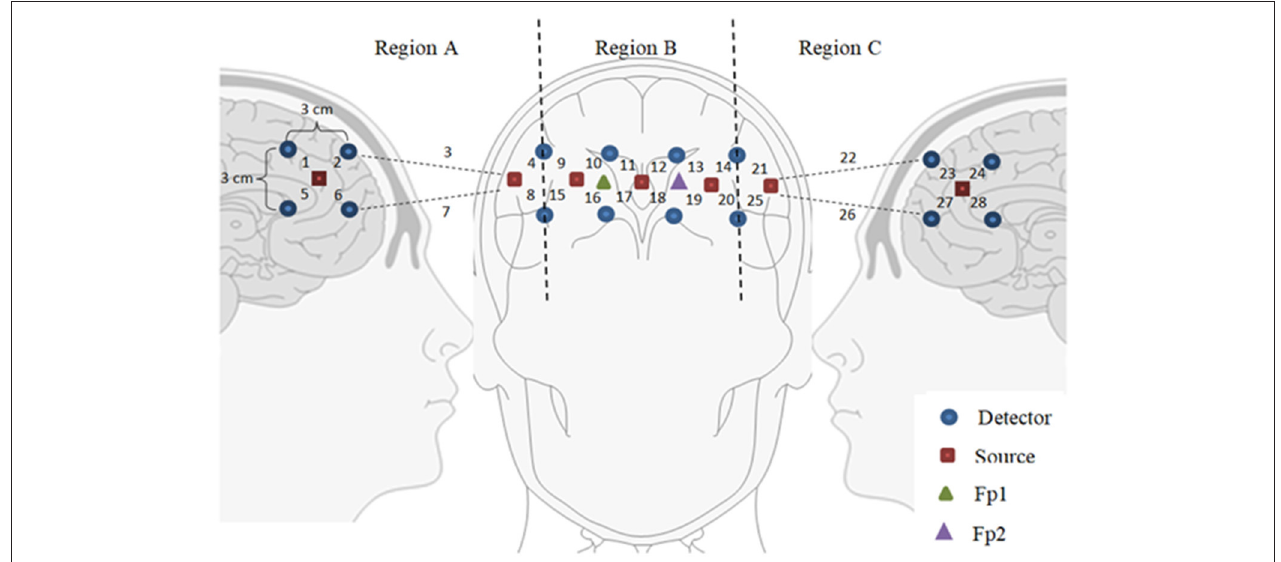
FIGURE 4 | Partitioning the prefrontal cortex: Only a subregion showing the highest accuracy can be used for brain-computer interface purposes (for example, Region A was used by Khan and Hong, 2015).